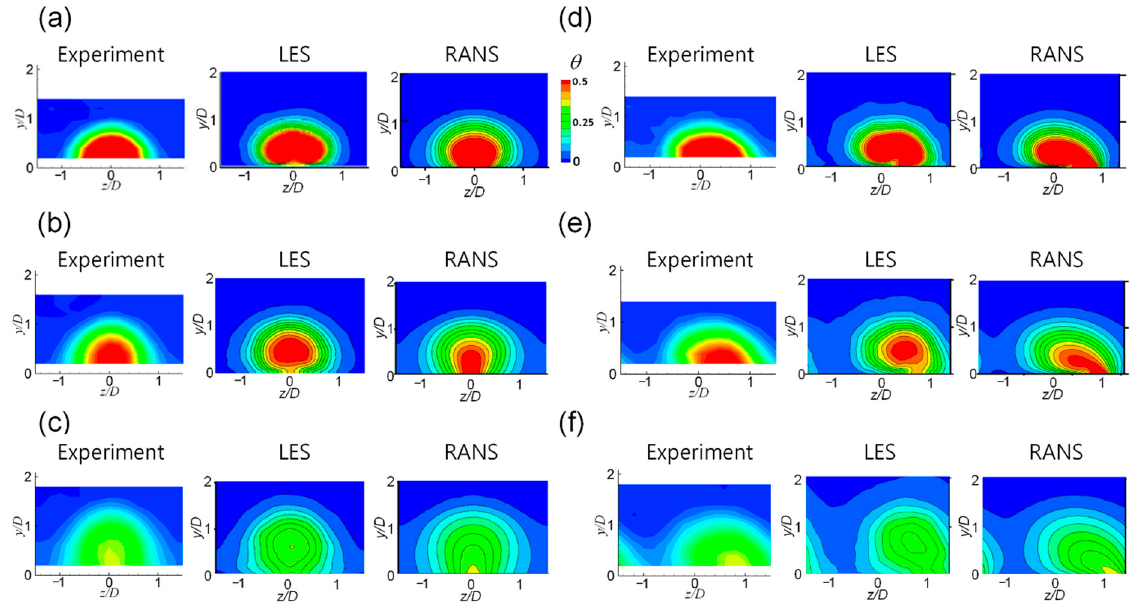
Figure 5. Boundary layer temperature distributions in the streamwise normal planes at M = 0.5: ( a ) x/D = 2.5, β = 0°; ( b ) x/D = 5.0, β = 0°; ( c ) x/D = 10.0, β = 0°; ( d ) x/D = 2.5, β = 30°; ( e ) x/D = 5.0, β = 30°; and ( f ) x/D = 10.0, β = 30°.